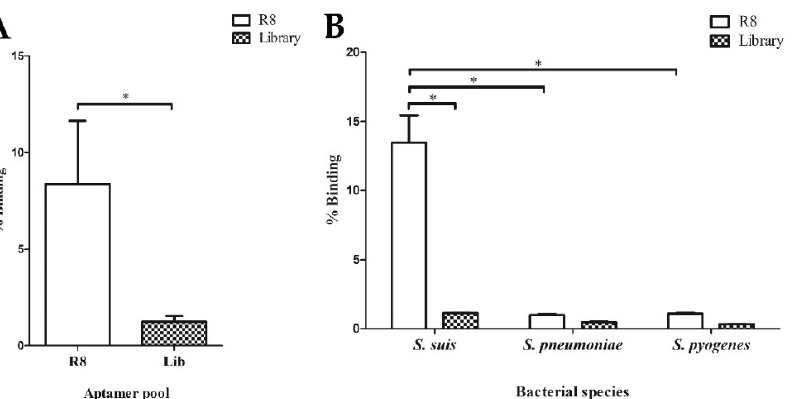
Figure 1. Characterization of RNA aptamer pool. ( A ) Enrichment of RNA aptamer pool derived from round eighth (R8) of cell-SELEX assay. The % binding of R8 RNA aptamer pool compared to the library (Lib) was presented. ( B ) Specificity of R8 RNA aptamer pool. The R8 RNA aptamer pool and random RNA Lib were tested with S. suis , S. pneumoniae , and S. pyogenes . * indicates the statistically significant difference using a Mann–Whitney U test ( p <